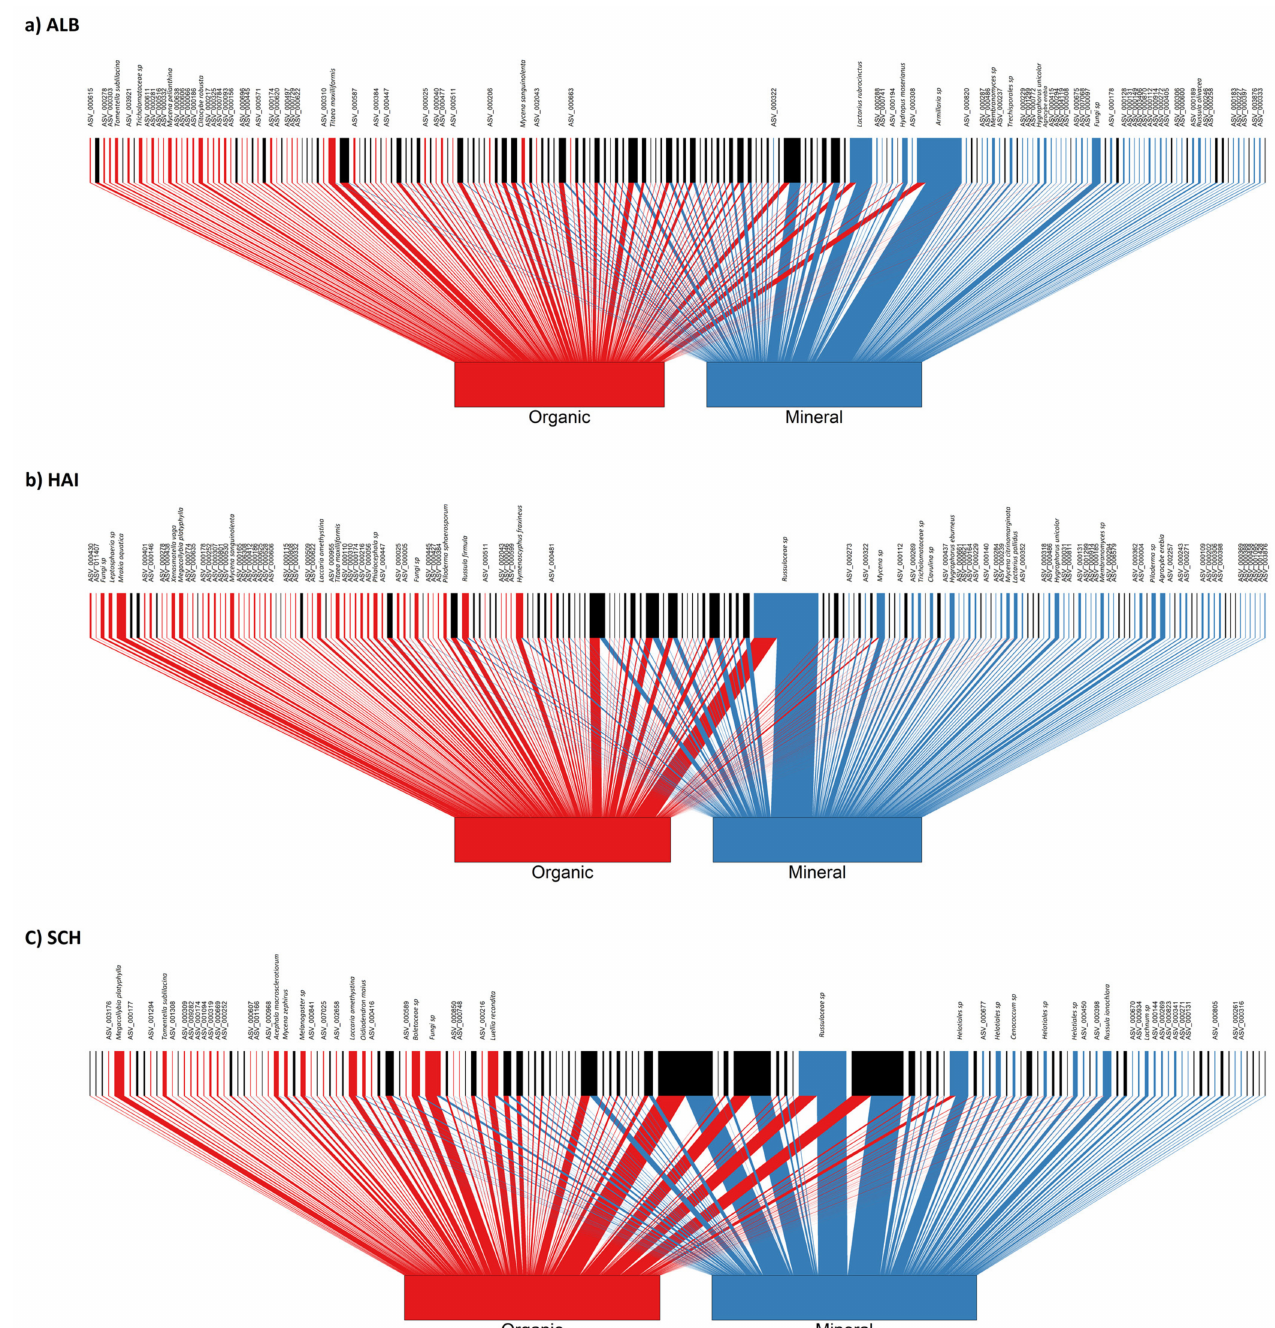
Figure 5. Bipartite network associations of root-associated fungi between organic layer and mineral soil in three biogeo- graphic regions. ( a ) ALB = Schwäbische-Alb, ( b ) HAI = Hainich-Dün and ( c ) SCH = Schorfheide Chorin. Upper nodes refer to fungal OTUs, and lower nodes refer to organic layer (red) and mineral soil (blue). The width of the upper nodes reflects the relative abundance of fungal OTUs from both soil layers. Line widths represent the relative abundances of the fungal OTUs from the respective soil layer. The statistically significant associations of root-associated fungal OTUs are shown in red for the organic layer and in blue for the mineral soil in the upper nodes. Black nodes represent non-significant fungal OTUs associations between the organic and mineral soil